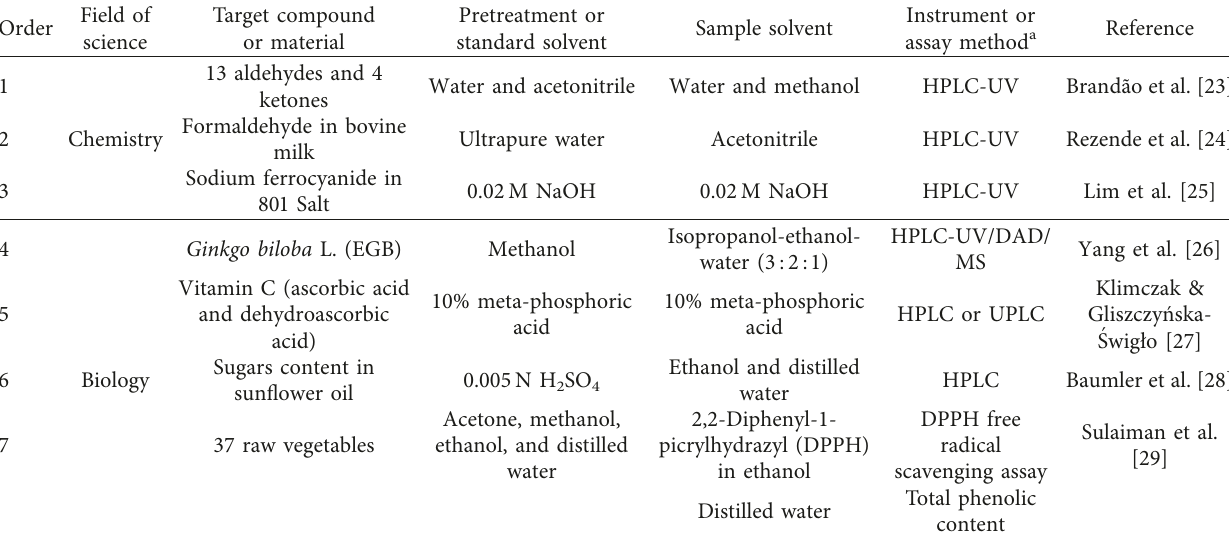
Table 5: List of the comparison of the solvent effects on chemical and biological analysis using the analytical instrument. Field Order